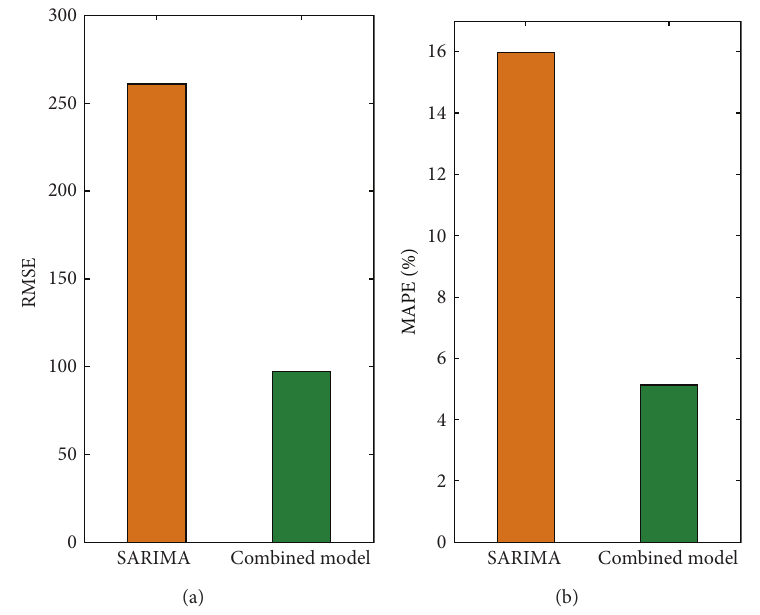
Figure 11: Bar figure of the RMSE and MAPE values.